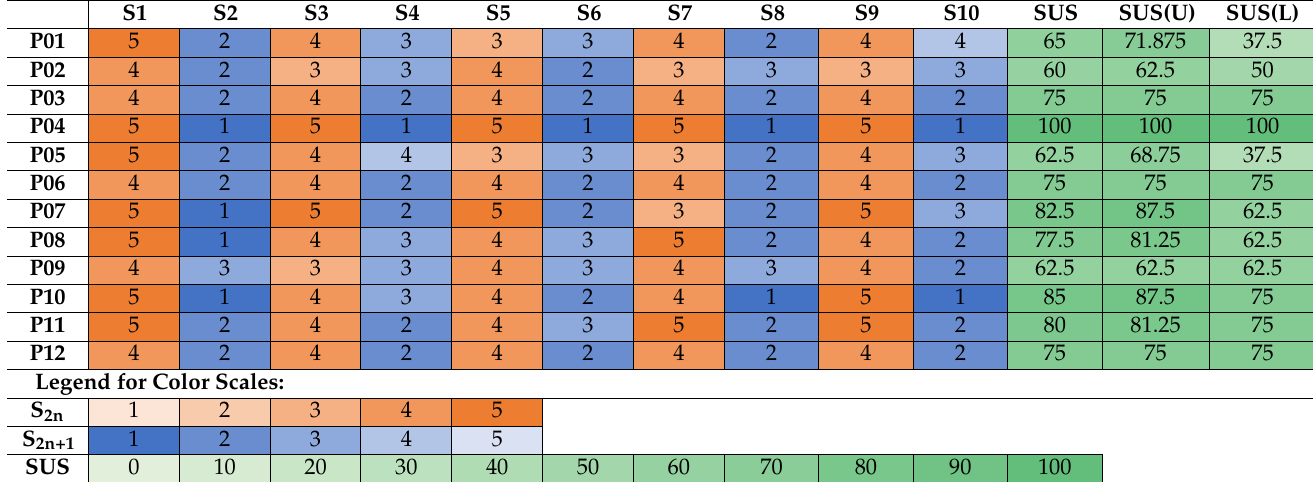
Table A6. Results of the application of the SUS questionnaire to 12 post-stroke patients at